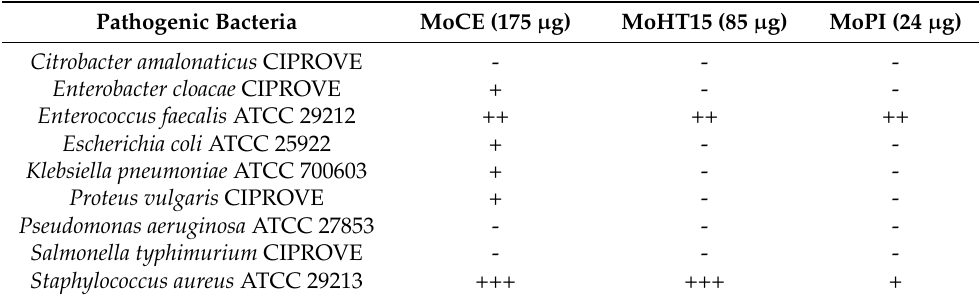
Table 5. Evaluation of the antibacterial activity of M. oleifera crude extract (MoCE), heat-treated sample (MoHT15) and the purified inhibitor